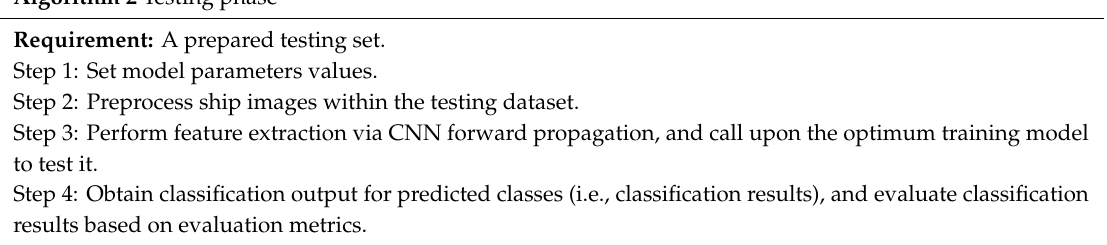
Algorithm 2 Testing